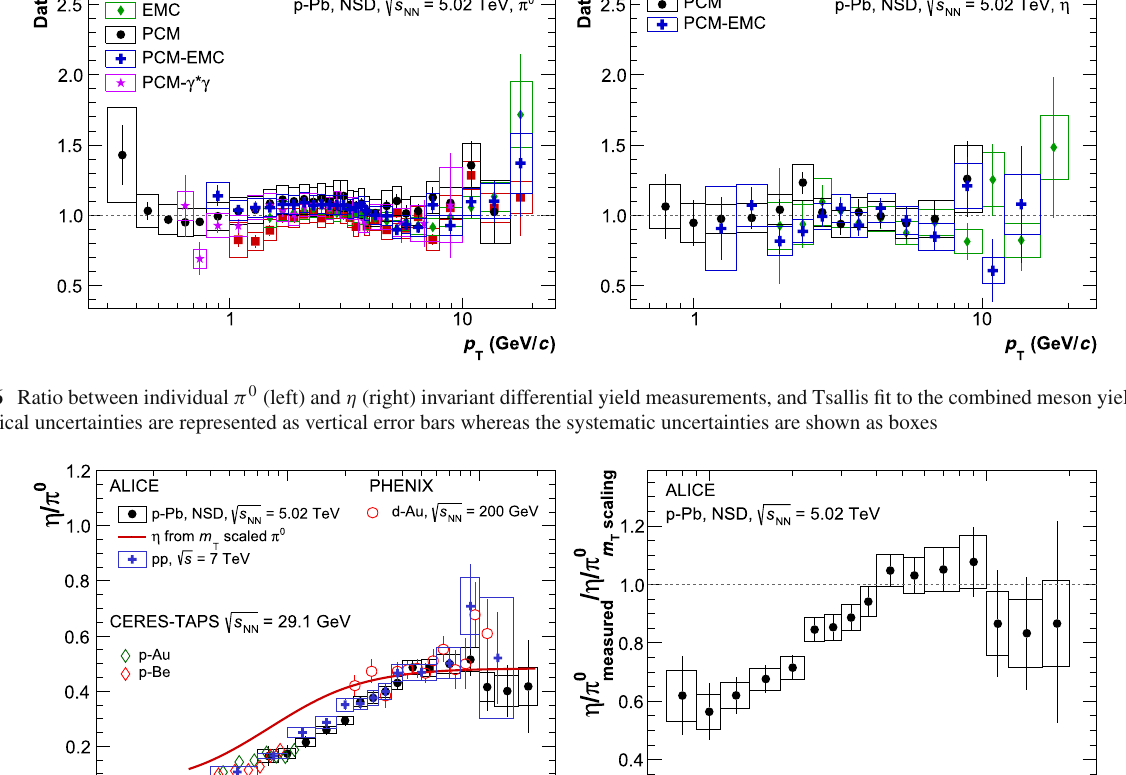
Fig. 7 Left: η / π 0 ratio as function of p lisions at − 1 . 365 < y cms < 0 . 435 at uncertainties are shown as vertical error bars. The systematic uncer- tainties are represented as boxes. For comparison, also the η / π 0 ratios measured in 7 TeV pp collisions with ALICE [33], in d-Au collisions